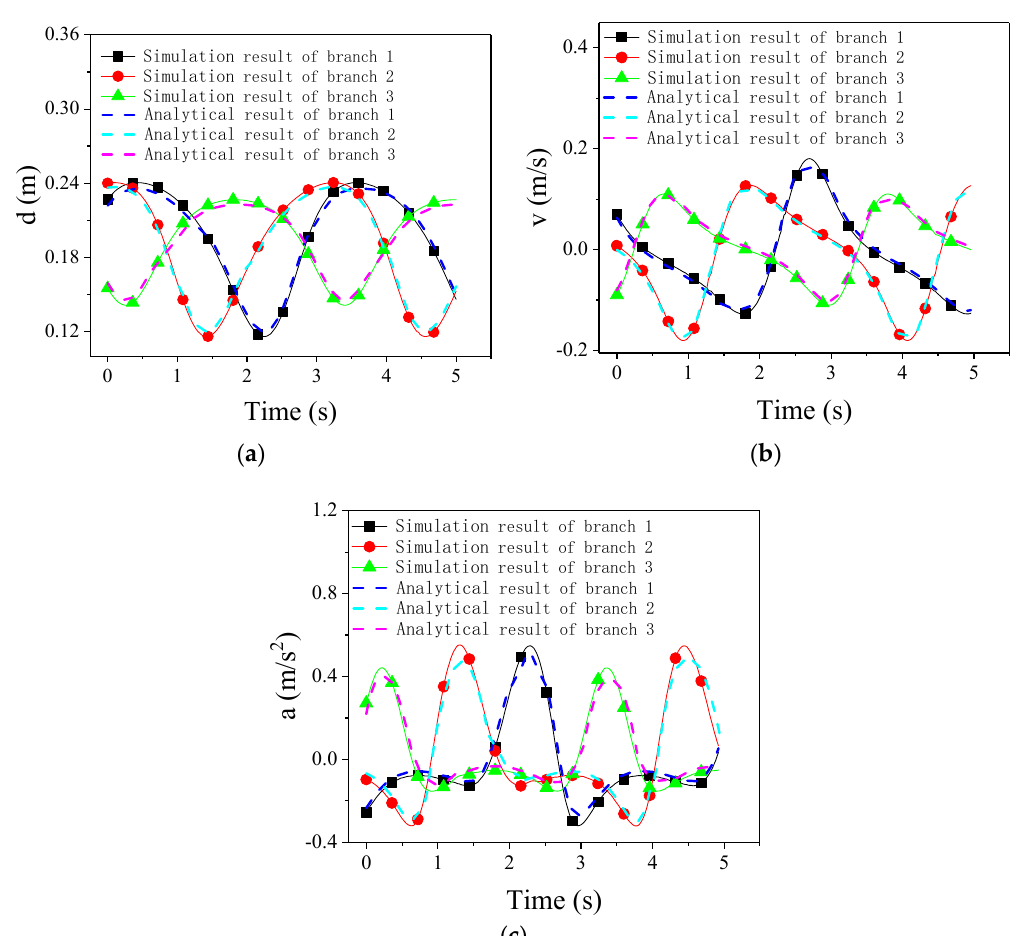
Figure 10. Displacement, velocity, and acceleration curves in the 3PUU moving part. ( a ) Displacement curves of each branched chain in 3PUU moving part; ( b ) velocity curves of each branched chain in 3PUU moving part; ( c ) acceleration curves of each branched chain in the 3PUU moving part.